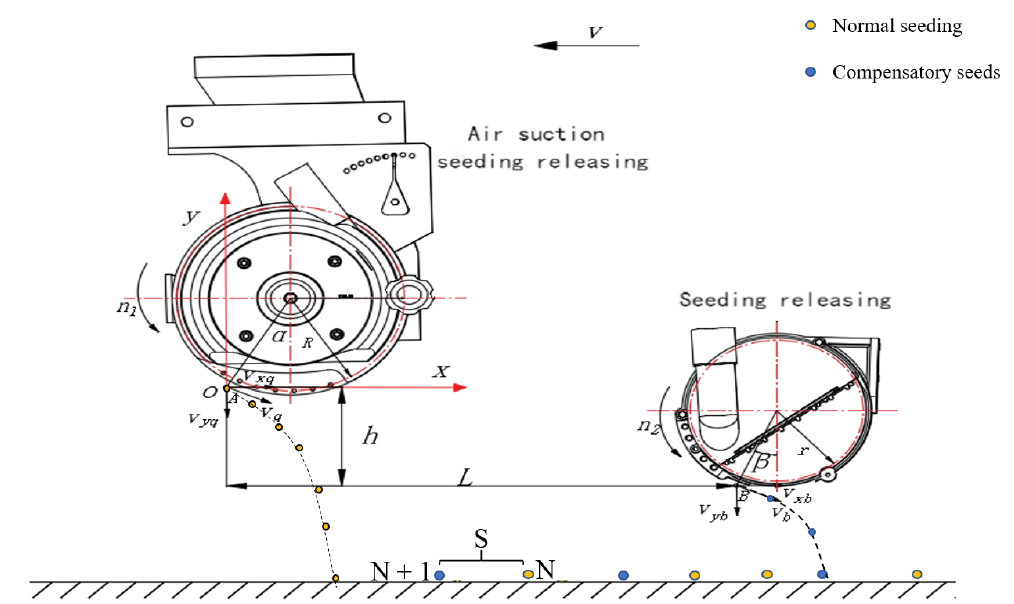
Figure 8. Parameter analysis diagram of reseeding system.